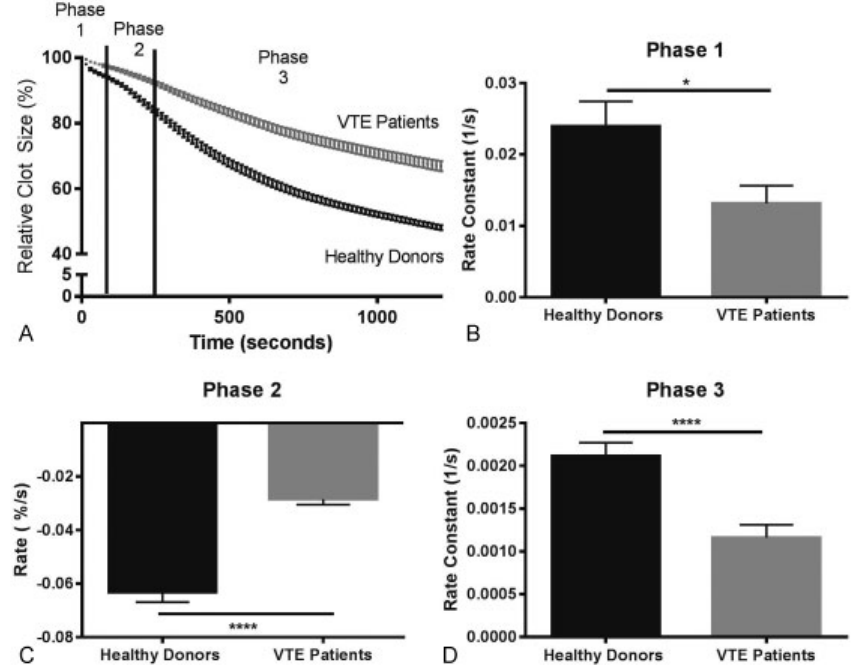
Fig. 4 ( A ) Averaged kinetic clot contraction curves obtained from clotting of the blood of VTE patients ( n ¼ 55) and healthy individuals ( n ¼ 60). Optical tracking was used to measure the relative changes in clot size over 20 minutes at 15-second intervals. ( B – D ) The rate constants of the three phases of clot contraction curves shown in A . The three phases correspond to the initiation of contraction (phase 1), linear contraction (phase 2), and mechanical stabilization (phase 3). Data are shown as mean (cid:3) SEM. (cid:5) p < 0.5; (cid:5)(cid:5)(cid:5)(cid:5) p <